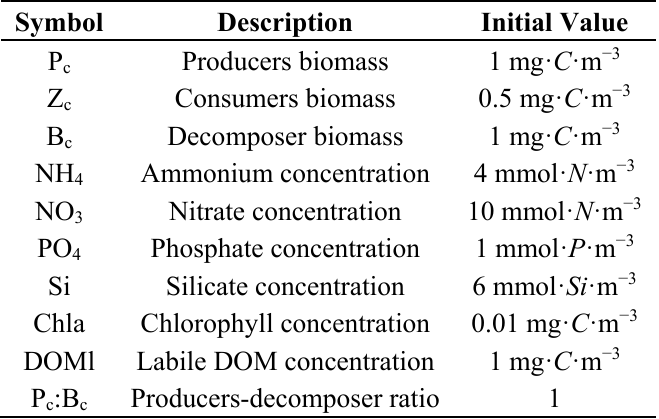
Table 1. Selected variables to assess model